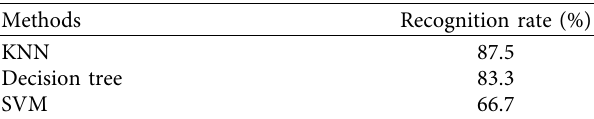
Table 7: KNN, decision tree, and SVM experimental results